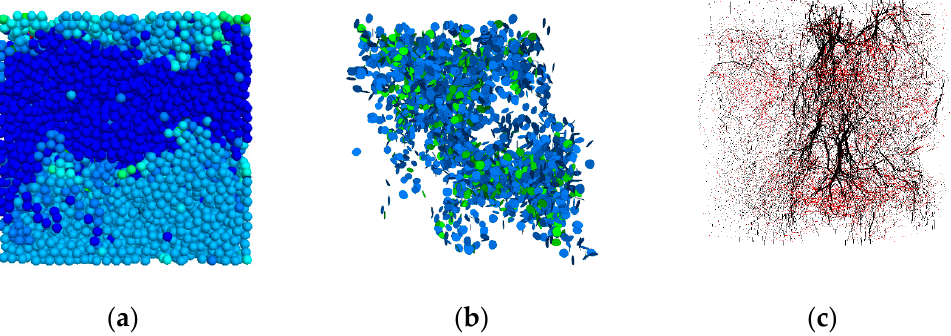
Figure 22. The failure mode of the foamed concrete with a density of 500 kg/m 3 at a loading rate of 0.06 mm/min. ( a ) model failure mode; ( b ) crack development; ( c ) force-chain distribution.